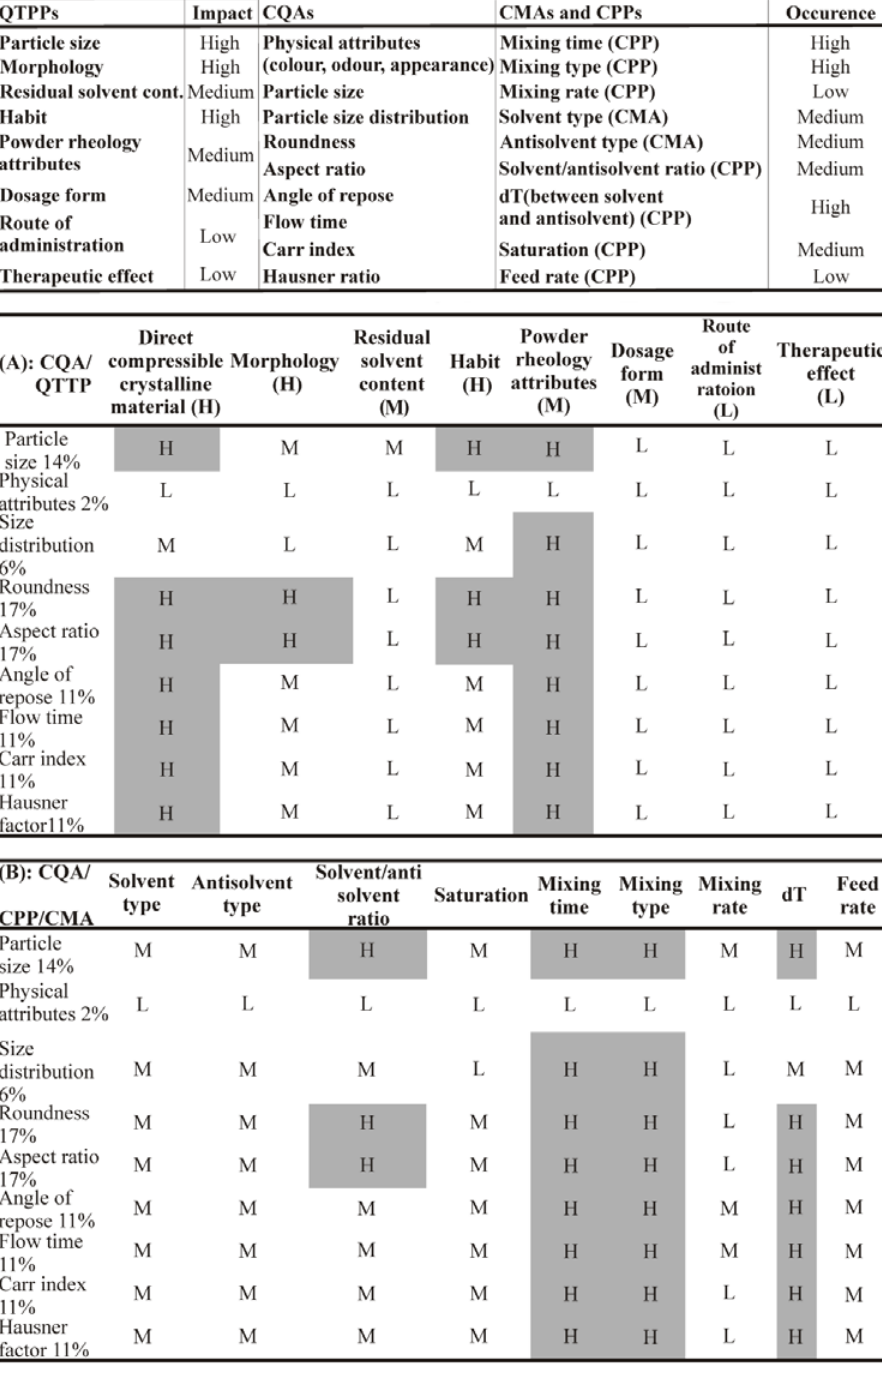
Figure 3. Selected quality target product profiles (QTPPs), critical material attributes (CMAs), critical process parameters (CPPs), and critical quality attributes (CQAs) and their impact on the crystallization system.